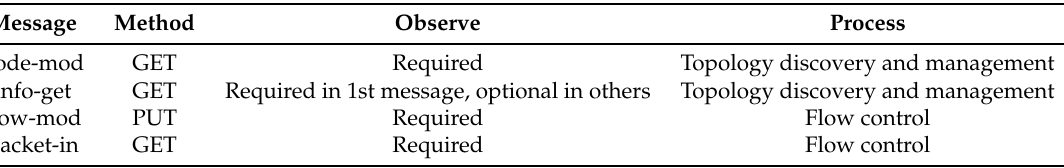
Table 3. SD6WSNP messages.